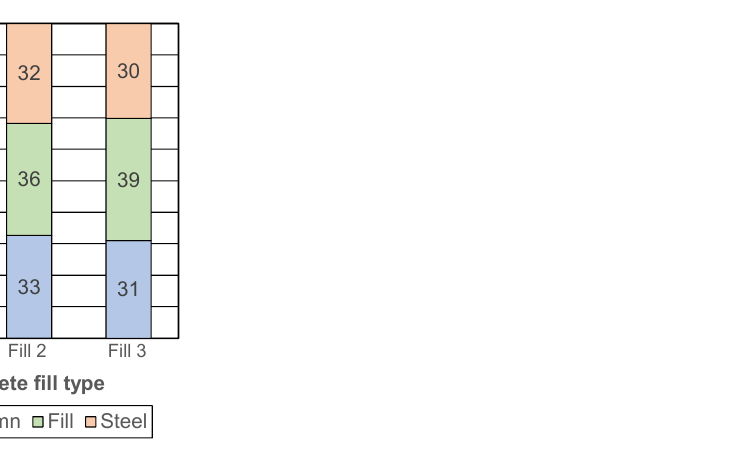
Figure 16. Comparative relationships for theoretical load distribution between three parts of the composite column.